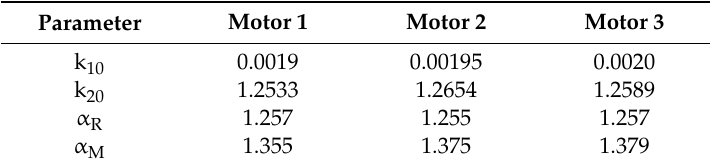
Figure 6. Ek and Eh change versus time. ( a ) Ek changes versus time, ( b ) Eh changes versus time.